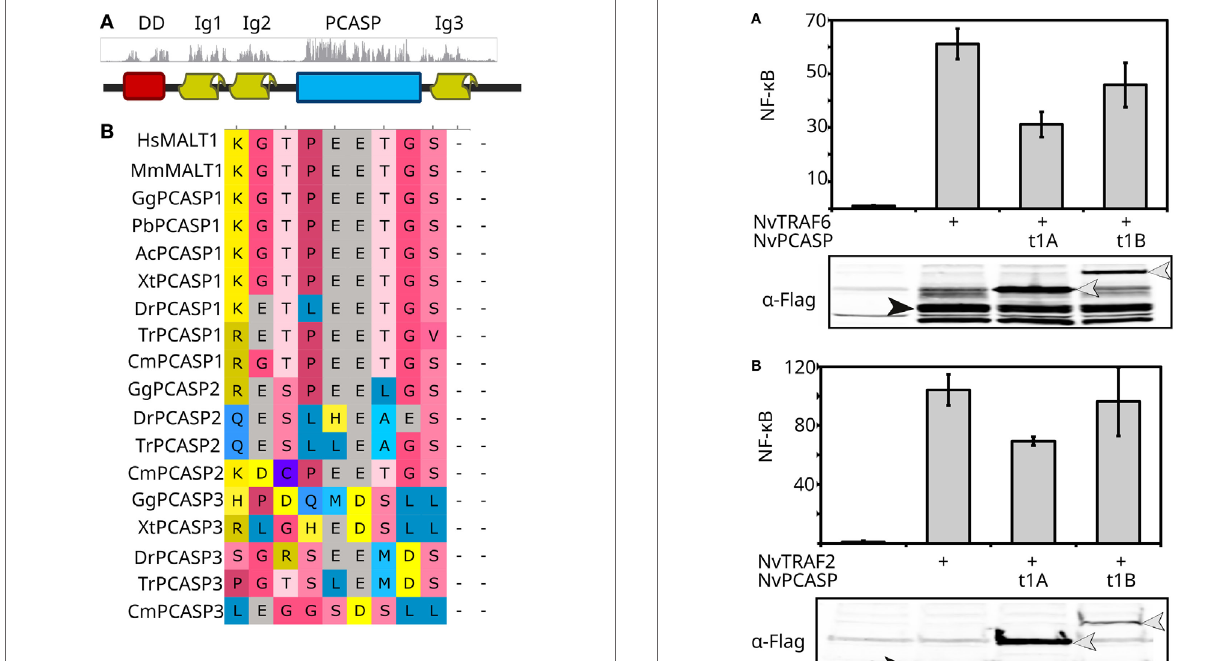
FigUre 3 | Domain conservation and TRAF6-binding evolution. (a) Conservation plot of a MUSCLE alignment from a wide selection of type 1 paracaspases from Cnidaria to humans. Conserved segments correspond well to annotated domains. (B) MUSCLE alignment segment of the most conserved TRAF6-binding site in the Ig3 domain. The corresponding sequence is missing in type 1 paracaspase homologs from organisms that diverged before the last common ancestor of jawed